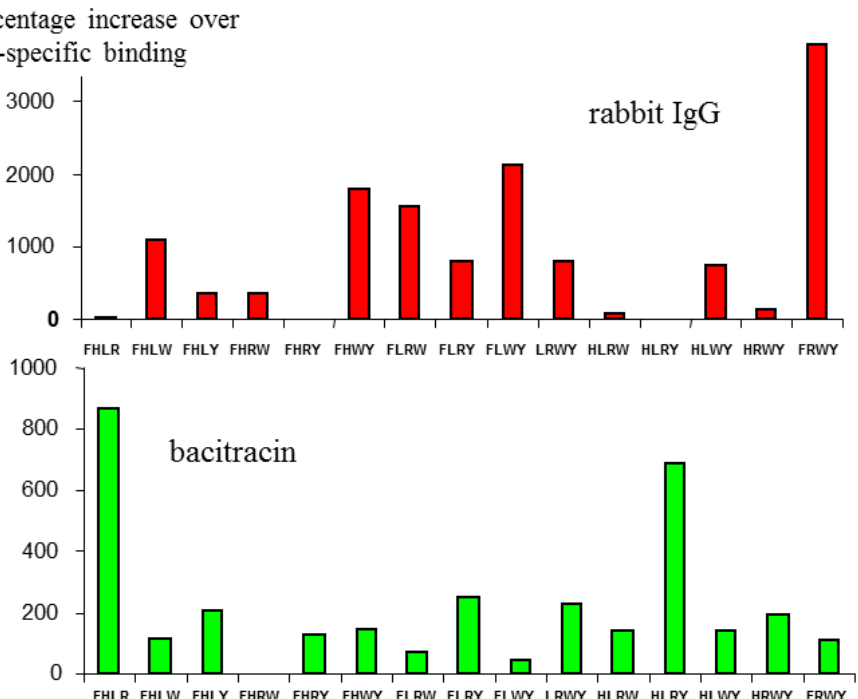
Figure 2. Binding of the same Mozaic micelle library to two different peptides. The different profiles observed demonstrate that binding is specific to particular amino acid combinations presented in the target